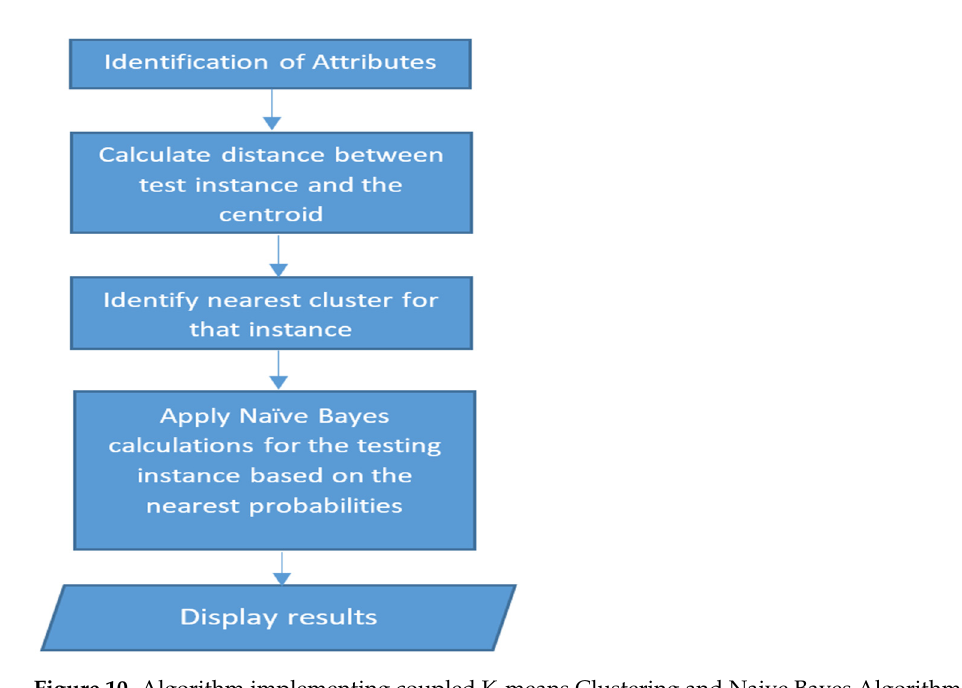
Figure 10. Algorithm implementing coupled K-means Clustering and Naive Bayes Algorithm.